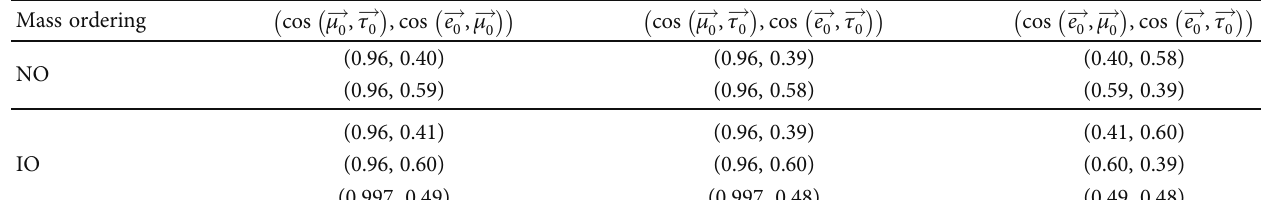
Table 4: Viable combinations with two included angles of the row vectors.